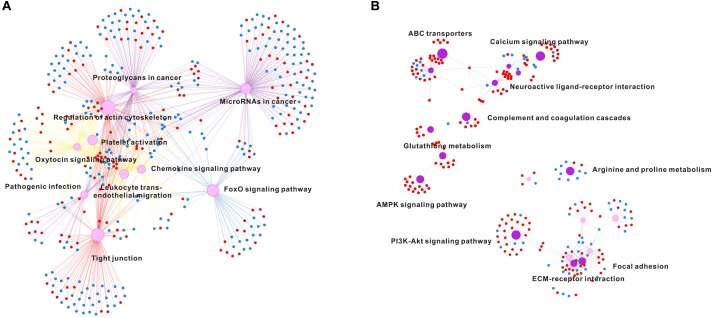
Pathway enrichment analysis in hypo-salinity (A) and hyper-salinity (B) adaptation. The top 10 enriched pathways are shown in the network. The up-regulated and down-regulated genes are indicated in red dot and blue dot, respectively.